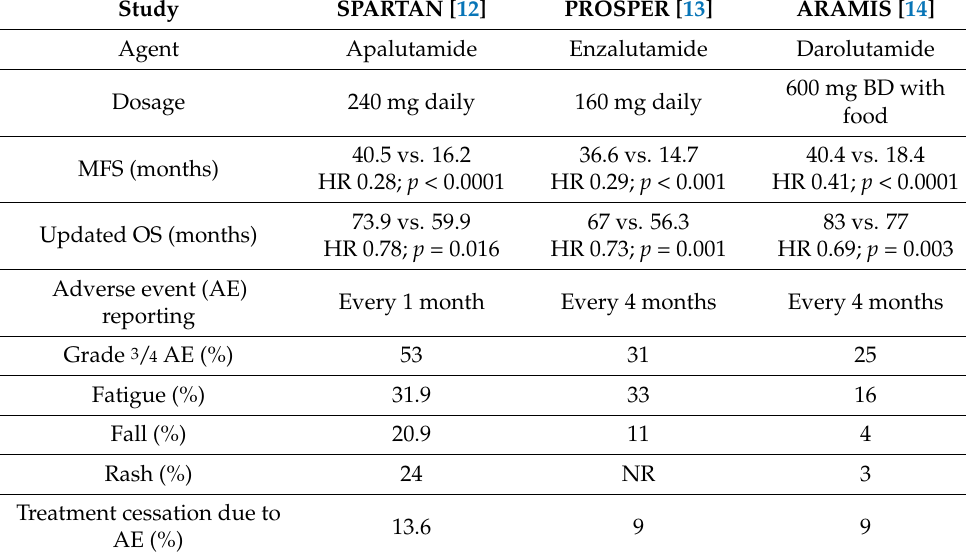
Table 1. Summary of non-metastatic castration-resistant prostate cancer (M0CRPC) treatment options.